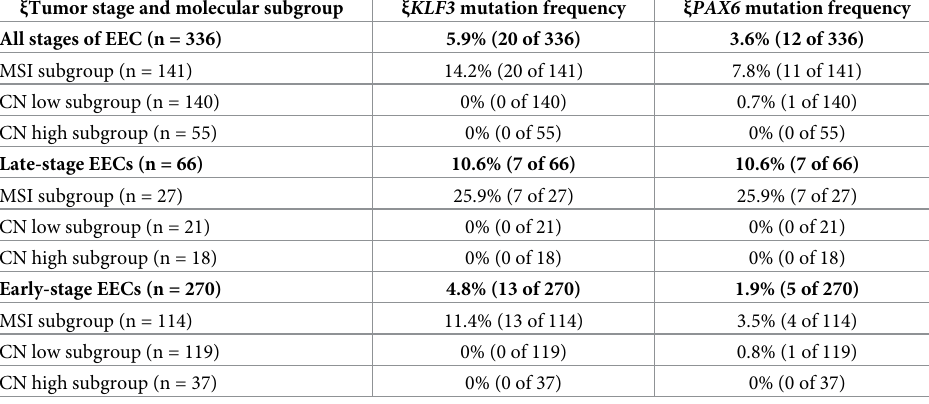
molecular subgroups ( Table 4 ). KLF3 mutations occurred exclusively in the MSI-hypermu- tated subgroup at an overall frequency of 14.2% (20 of 141 cases), which was significantly higher than the occurrence of KLF3 mutations among the combined CN-high and CN-low subgroups (0 of 195 cases) (p-value < 0.0001 2-tailed Fisher’s exact test). Within the MSI- hypermutated subgroup, KLF3 was mutated in 25.9% (7 of 27) of late-stage tumors versus 11.4% (13 of 114) of early-stage tumors. There were no statistically significant differences in KLF3 mutation frequency according to tumor grade; mutations were present in 14.2% of grade 1 (4 of 28), 8.1% of grade 2 (3 of 37), and 13.2% of grade 3 (11 of 83) MSI tumors ( Table J in S1 Table ). All but one (11 of 12) of PAX6 mutations were in the MSI subgroup; the PAX6 X306_splice mutation was present in a CN-low tumor ( Table 4 ). The higher frequency of PAX6 mutations Table 4. Frequency of non-silent KLF3 and PAX6 mutations in non-ultramutated EECs, according to molecular subgroup. ξ Tumor stage and molecular